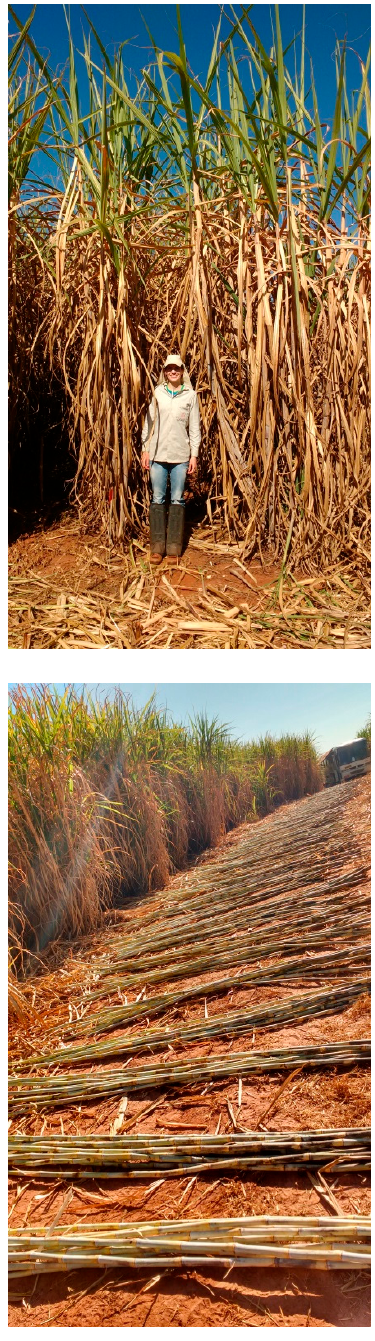
Figure A1. Photos of the experimental area with sugarcane plant samples for technological quality. Suzanapólis—SP, Brazil.